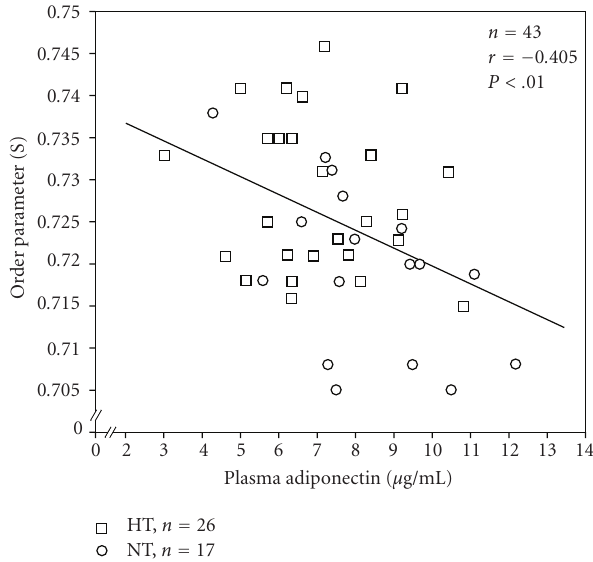
Figure 4: Inverse correlation between plasma 8-iso-PG F2 α and plasma adiponectin levels in hypertensive and normotensive men.